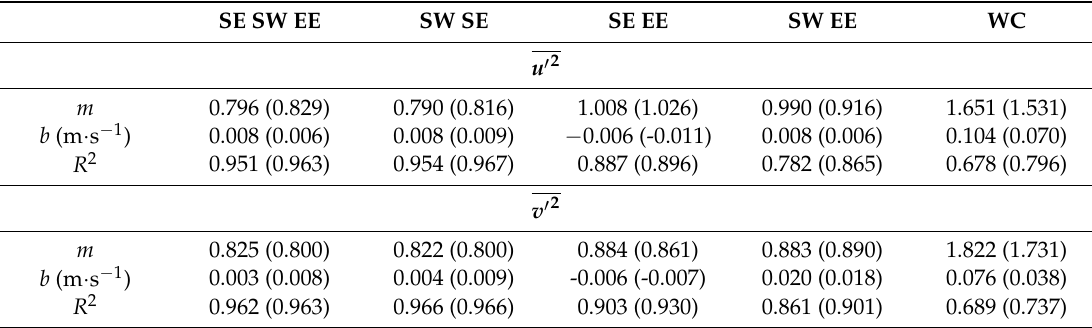
Table 3. Summary of the linear-regression statistics for u (cid:48) 2 and v (cid:48) 2 for different lidar configurations; values in brackets are statistics for which periods with u sonic < 4 m · s − 1 have been excluded; R 2 is the goodness of the fit, m is the slope and b the intersect of the of the linear regression. SE SW EE SW SE SE EE SW EE WC u (cid:48)